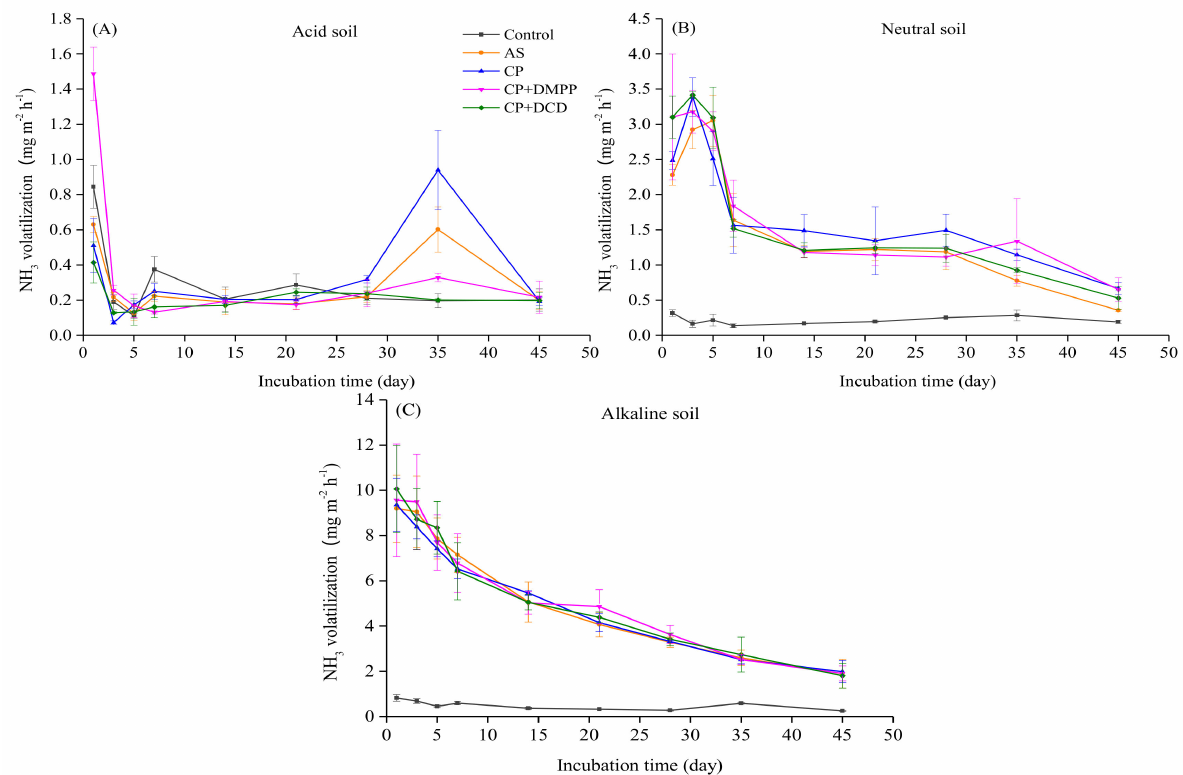
Figure 4. Dynamics of the rate of ammonia volatilization of different treatments in the acid ( A ), neutral ( B ), and alkaline soils ( C ) under each sampling day during the incubation. Error bars represent standard deviations (n =